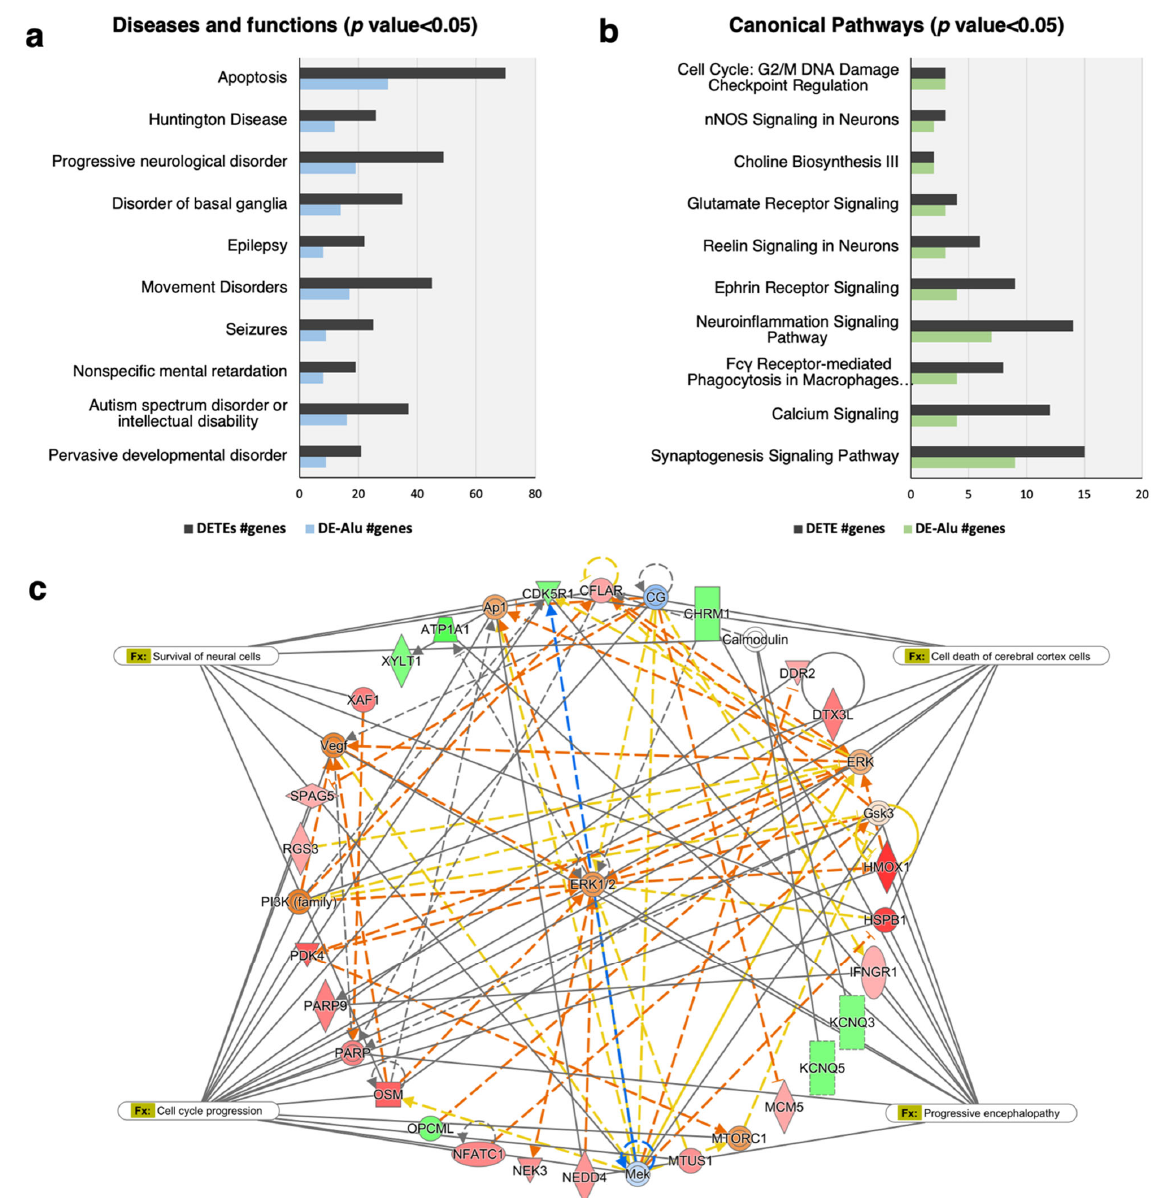
Figure 4. Functions and pathways of DEGs significantly correlating with DE ‐ Alu elements in the prefrontal cortex of ASD individuals predicted by IPA software: ( a ) Diseases and functions associ ‐ ated with DEGs. ( b ) Canonical pathways associated with DEGs. ( c ) The gene regulatory network associated with DEGs was generated using IPA software. Red indicates upregulated genes and green indicates downregulated